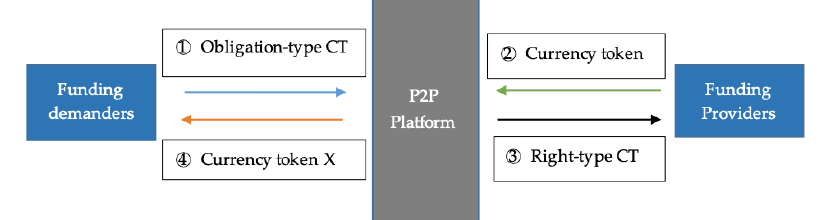
Figure 8. P2P Financing. Figure 8. P2P Algorithm 4 The processes and the operations of P2P financing